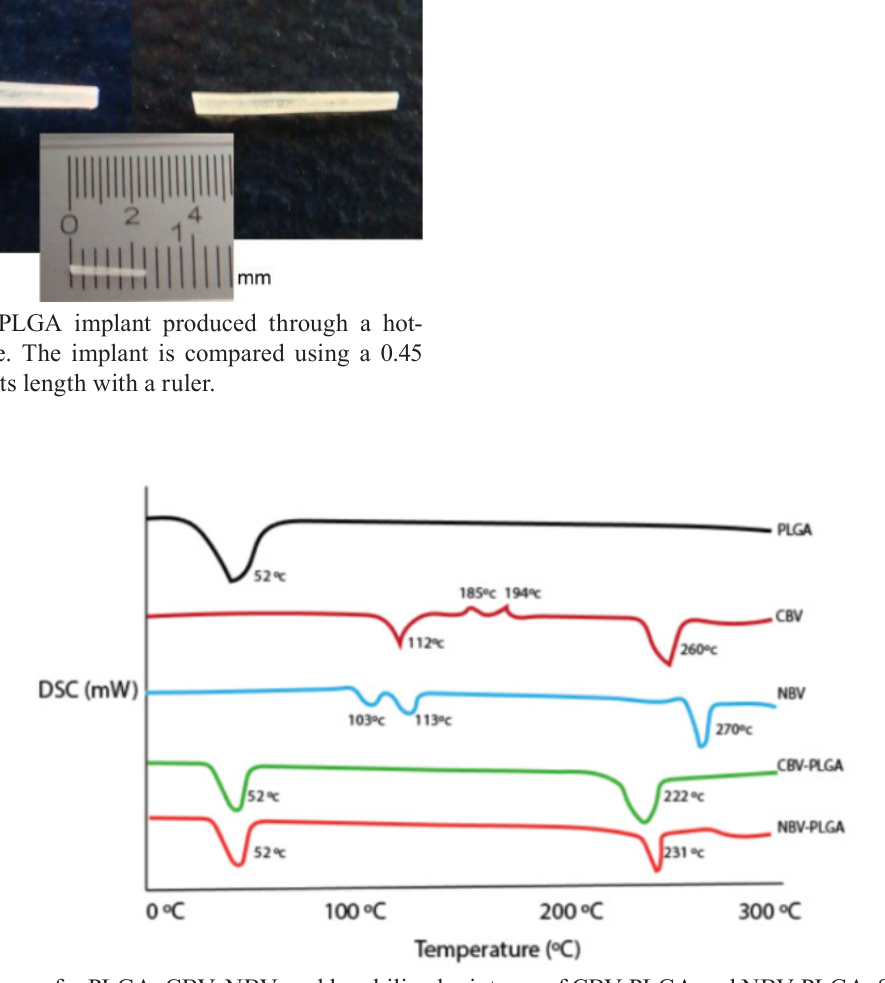
FIGURE 2 - DSC curves for PLGA, CBV, NBV, and lyophilized mixtures of CBV-PLGA and NBV-PLGA. Samples were heated from 0 to 300 ºC.